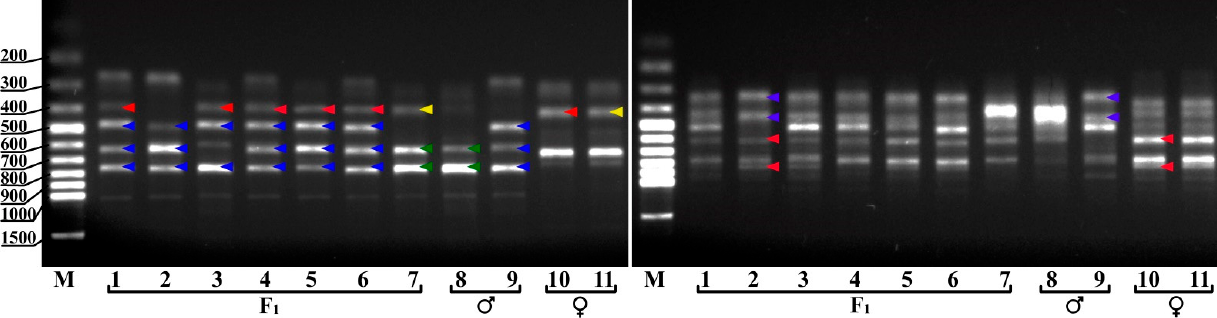
‘NC’ No. 1-1, No. 1-2, No. 1-5, No. 2-2, No. 4-2, No. 4-8; 7— V.ul. 8 × ‘SC 5-8’ No. 7-9; 8—‘SC 5-8 ( ♂1 )’; 9 -’NC’ ( ♂ 2); 10— V.